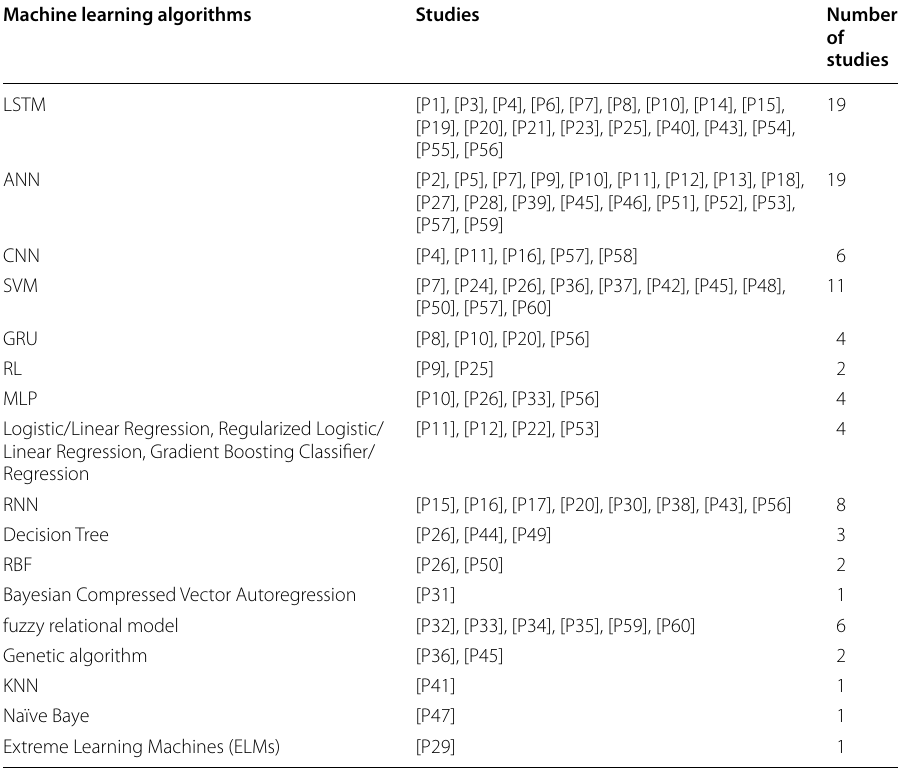
Table 6 Showing machine learning models and studies that made use of it Machine learning algorithms Studies Number